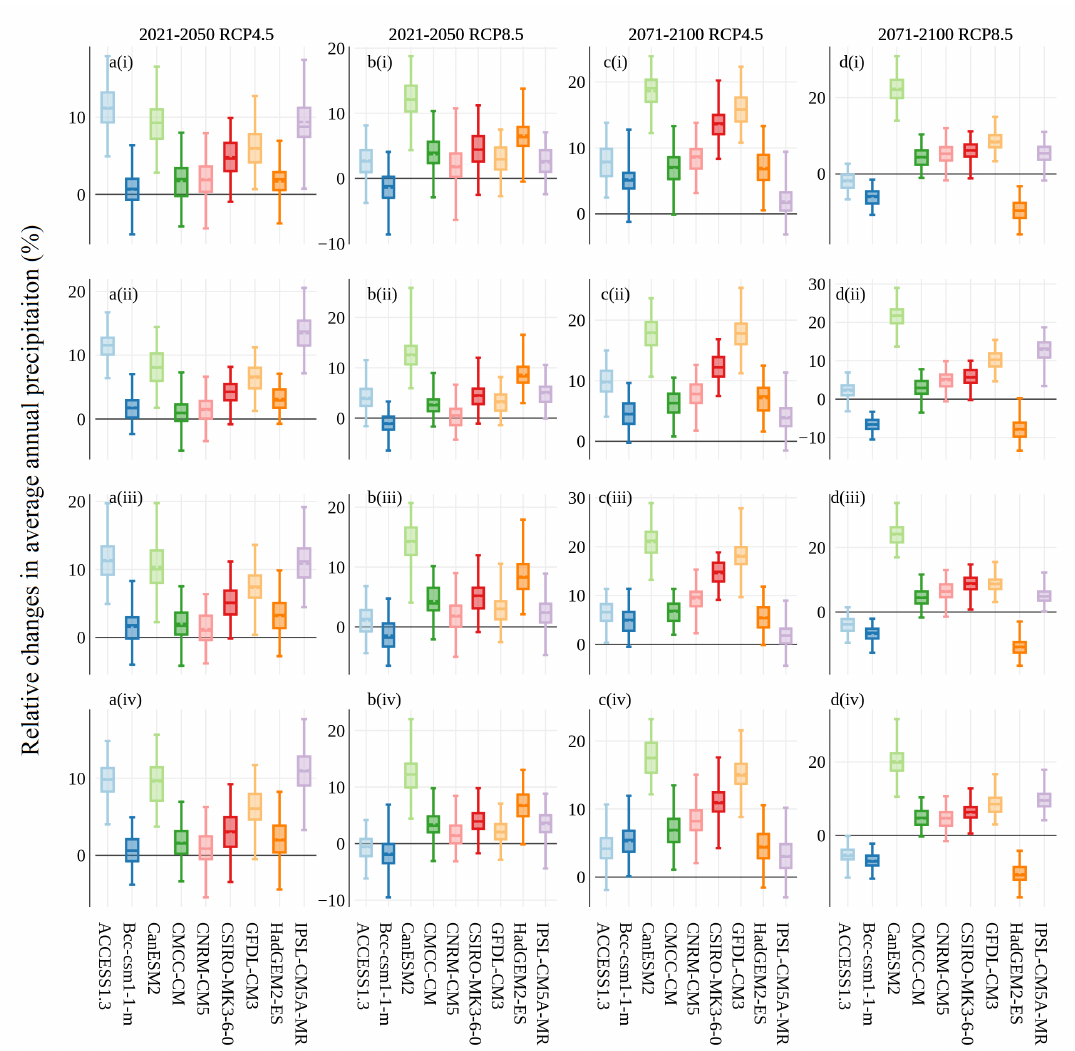
Figure 4. Relative changes (%) in long-term average annual precipitation from downscaled GCM data for: ( a ) 2021–2050 period under RCP4.5 scenario; ( b ) 2021–2050 period under RCP8.5 scenario; ( c ) 2071–2100 period under RCP4.5 scenario; and ( d ) 2071–2100 period under RCP8.5 scenario relative to observed values during 1985–2014. Rows ( i – iv ) denote results for stations S06, S23, S24, and S25, respectively. The bottom, middle, and top of the box denote the first, second, and third quartiles, respectively. The lower and upper ends of the whiskers represent the minimum and maximum values,